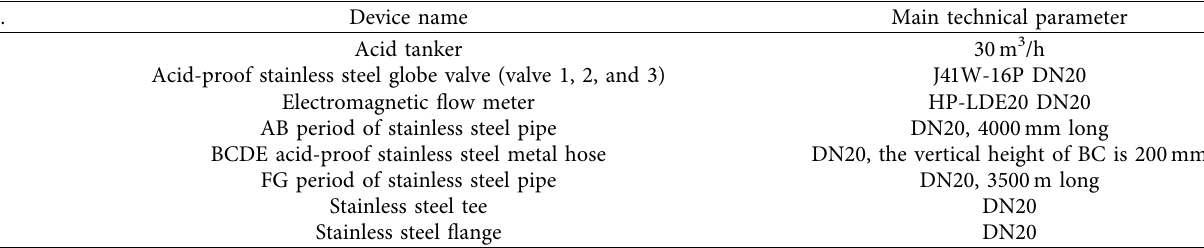
Figure 4: Schematic diagram of temporary acid adding system for high-discharge waste Table 1: Main equipment and equipment parameter table.